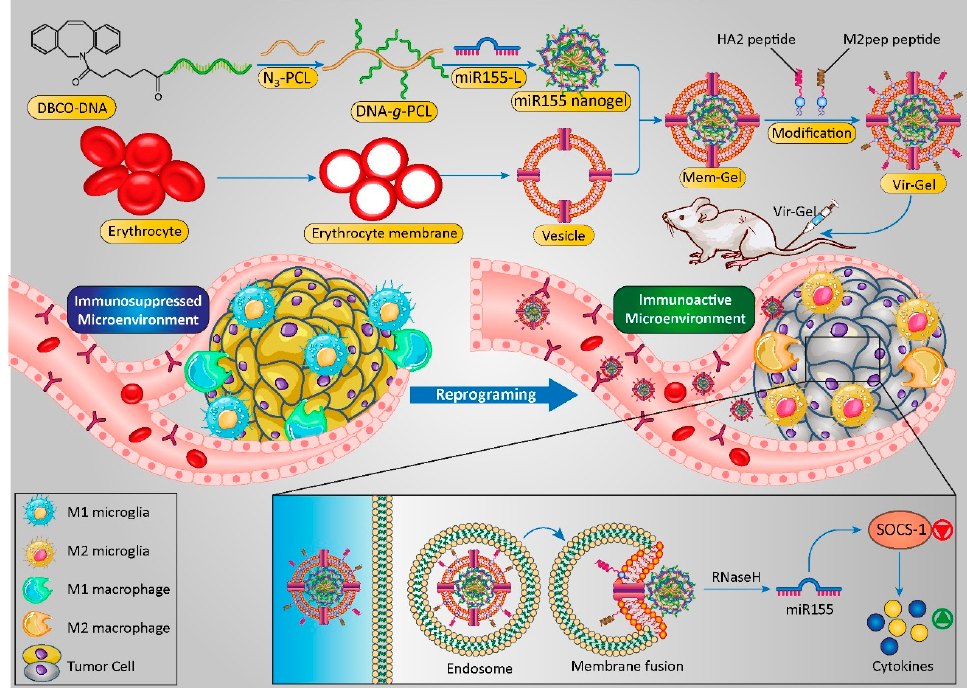
Figure 9. Scheme of virus-like nanoparticles used for GBM immunotherapy. This new type of vehicle was fabricated via the utilization of the erythrocyte’s membrane containing two types of peptides in the structure of the membrane and the entrapment of microRNA nanogel inside itself. The transmembrane peptides targeted the particles towards M2-phase macrophages and miRNA enhanced the polarization of macrophages to M1 phase. Reproduced from [227].